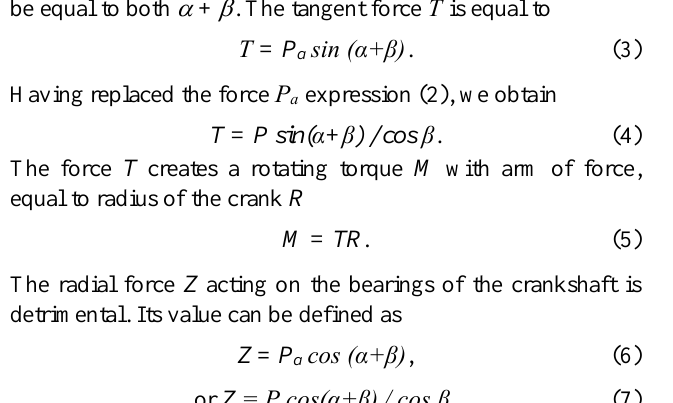
Fig. 1. Forces of pressure. Transposition of the piston is accompanied by impact on the walls of the cylinder, increasing deterioration of the cylinder liner and causing additional noise (vibration).